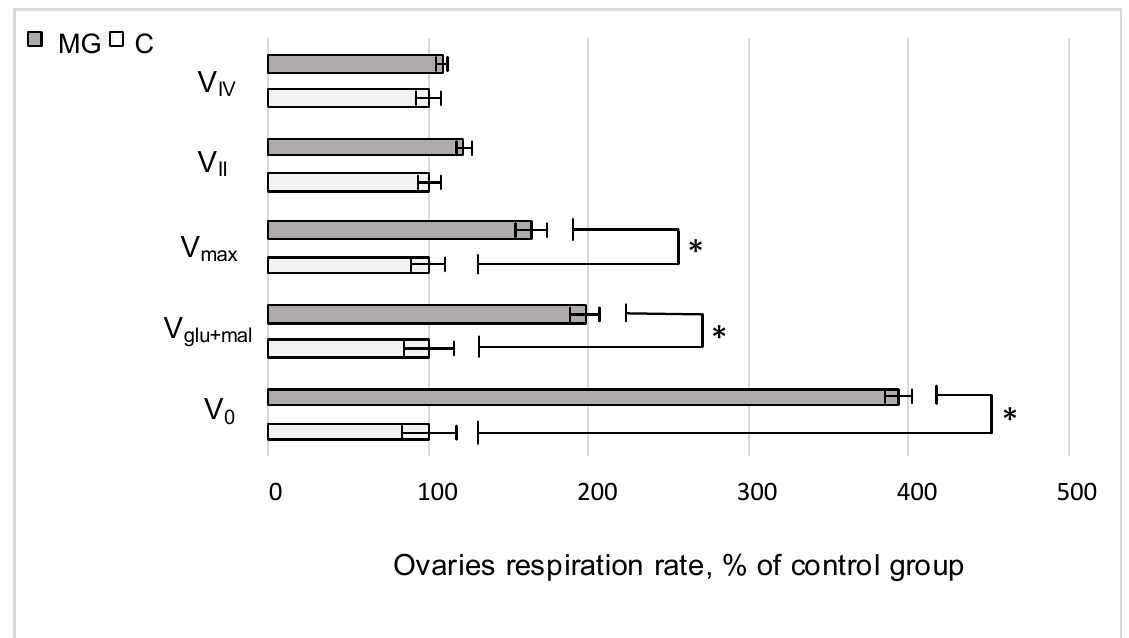
Figure 1. Relative values of the rate of cellular respiration of Drosophila melanogaster ovaries. V 0 —cellular respiration rate of permeabilized ovaries; V Glu+Mal —the rate of cellular respiration with the addition of 10 mM glutamate + 5 mM malate; V max —the maximum rate of cellular respiration after the addition of 2 mM ADP; V II —the rate of cellular respiration with the sequential addition of 0.5 mM rotenone (NADH dehydrogenase inhibitor) and 10 mM succinate (succinate dehydrogenase substrate); V IV —the rate of cellular respiration upon the sequential addition of 5 mM antimycin (an inhibitor of cytochrome c reductase) and 0.5 mM TMPD + 2 mM ascorbate (artificial substrates of cytochrome c oxidase). C—control group; MG—group of simulated microgravity. * p < 0.05 compared to the control group C.